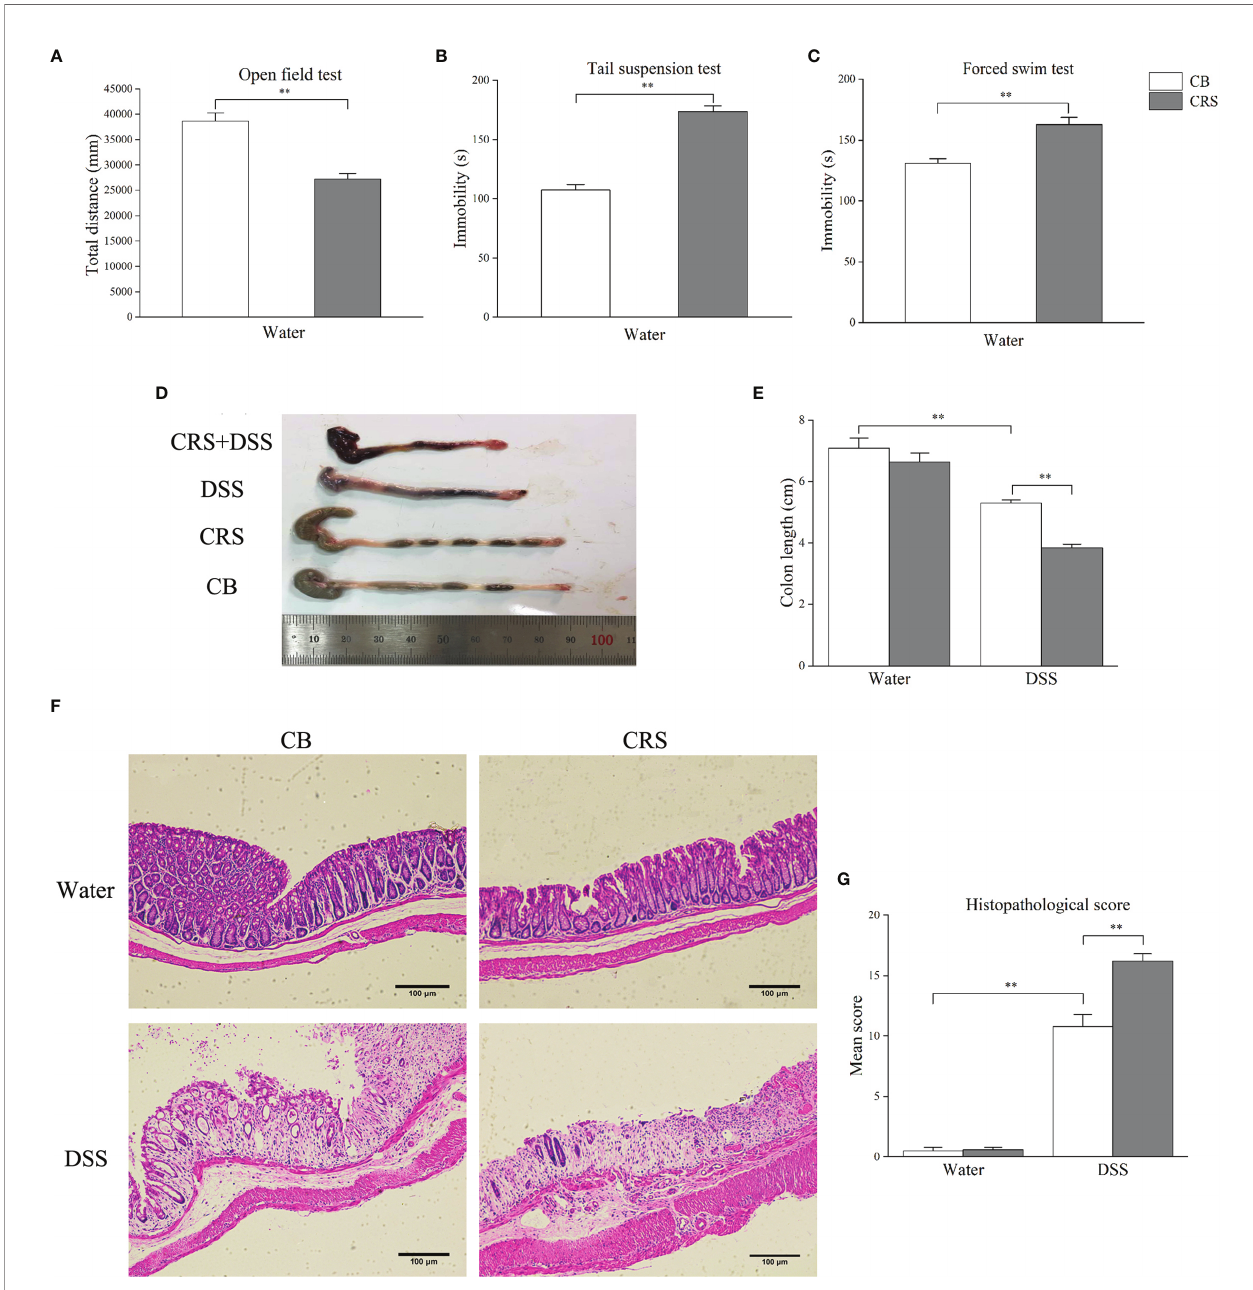
FIGURE 2 | CRS aggravated DSS-induced colon injury. (A – C) Behavioral tests were performed before DSS, including OFT, TST, FST (n = 8). (D) Representative pictures of colon were selected between groups; (E) Colon length was recorded from each group (n = 6 – 8). (F) Representative pathological pictures of colonic injury were selected between groups (magni fi cation ×40, scale bar: 100 m m). (G) Colonic injury score was assessed by histopathological score based on H&E staining (n = 5). *p < 0.05, **p <